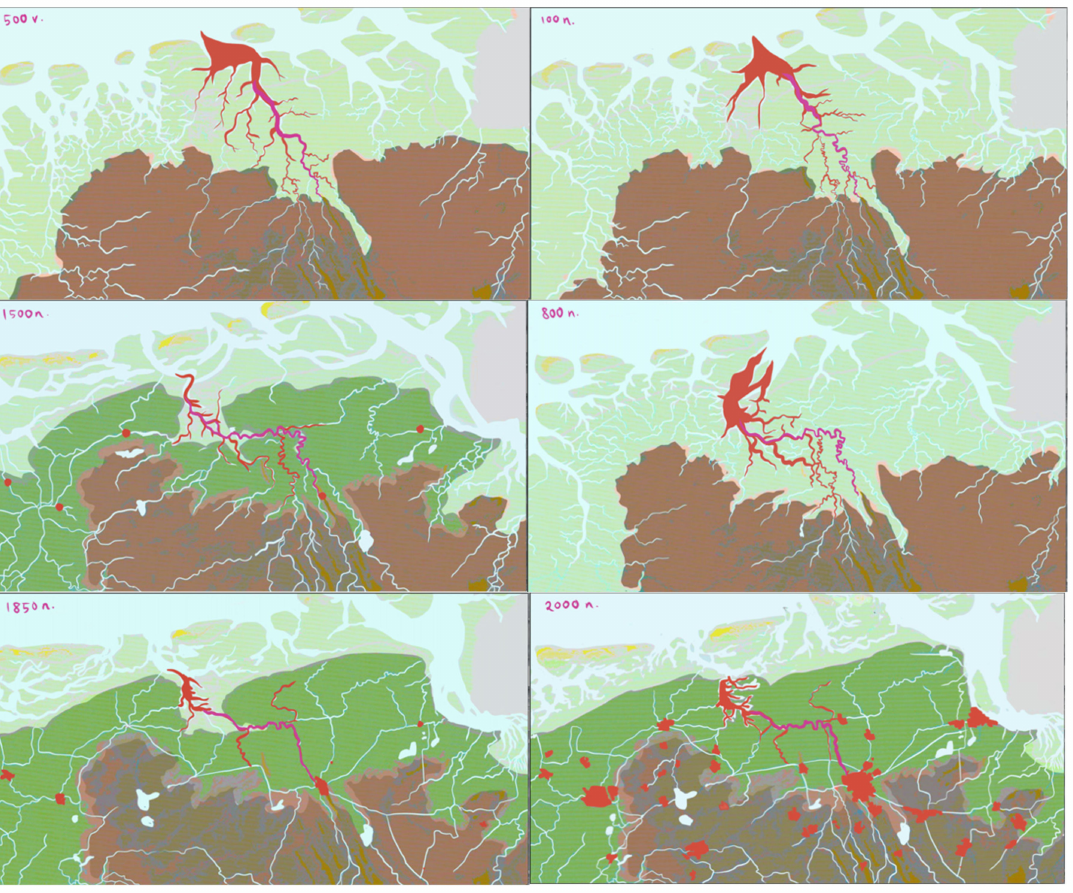
Figure 8. Landscape genesis from 500 BC until 2000 AC. The current managed landscape is non-resilient and provides safety by agreement. Real safety is debatable as a breakthrough of the strongest dike implies a huge